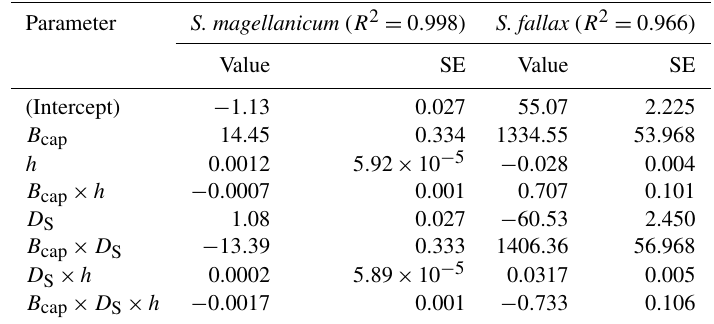
Table B3. Parameter estimates of the linear model for the log 10 -transformed capitulum evaporative resistance ( r bulk ) for S. fallax and S. magellanicum . The estimated value, the standard error (SE), and the test statistics ( p values) are given for the predictors of the models. The predictors are the capitulum biomass ( B cap ), the capitulum density ( D S ), the water potential ( h ), the interaction of capitulum biomass and water potential ( B cap × h ), the interaction of capitulum biomass and capitulum density ( D S × h ), the interaction of capitulum density and water potential ( D S × h ), and the interaction of capitulum biomass, capitulum density, and water potential ( B cap × D S × h ). All coefficient values are significantly different from zero ( p < 0 .